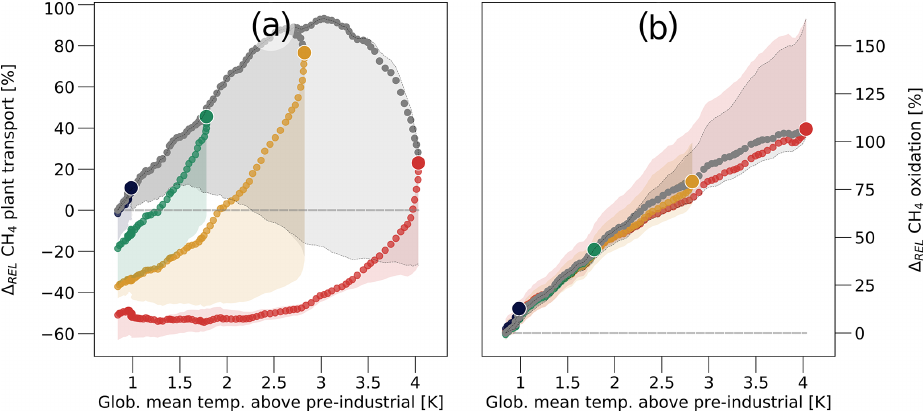
Figure 13. Methane transport. Relative change in (a) amount of methane that is taken up by roots and emitted at the surface and (b) amount of methane that is oxidized within the soil. Colours and symbols have the same meaning as in Fig.